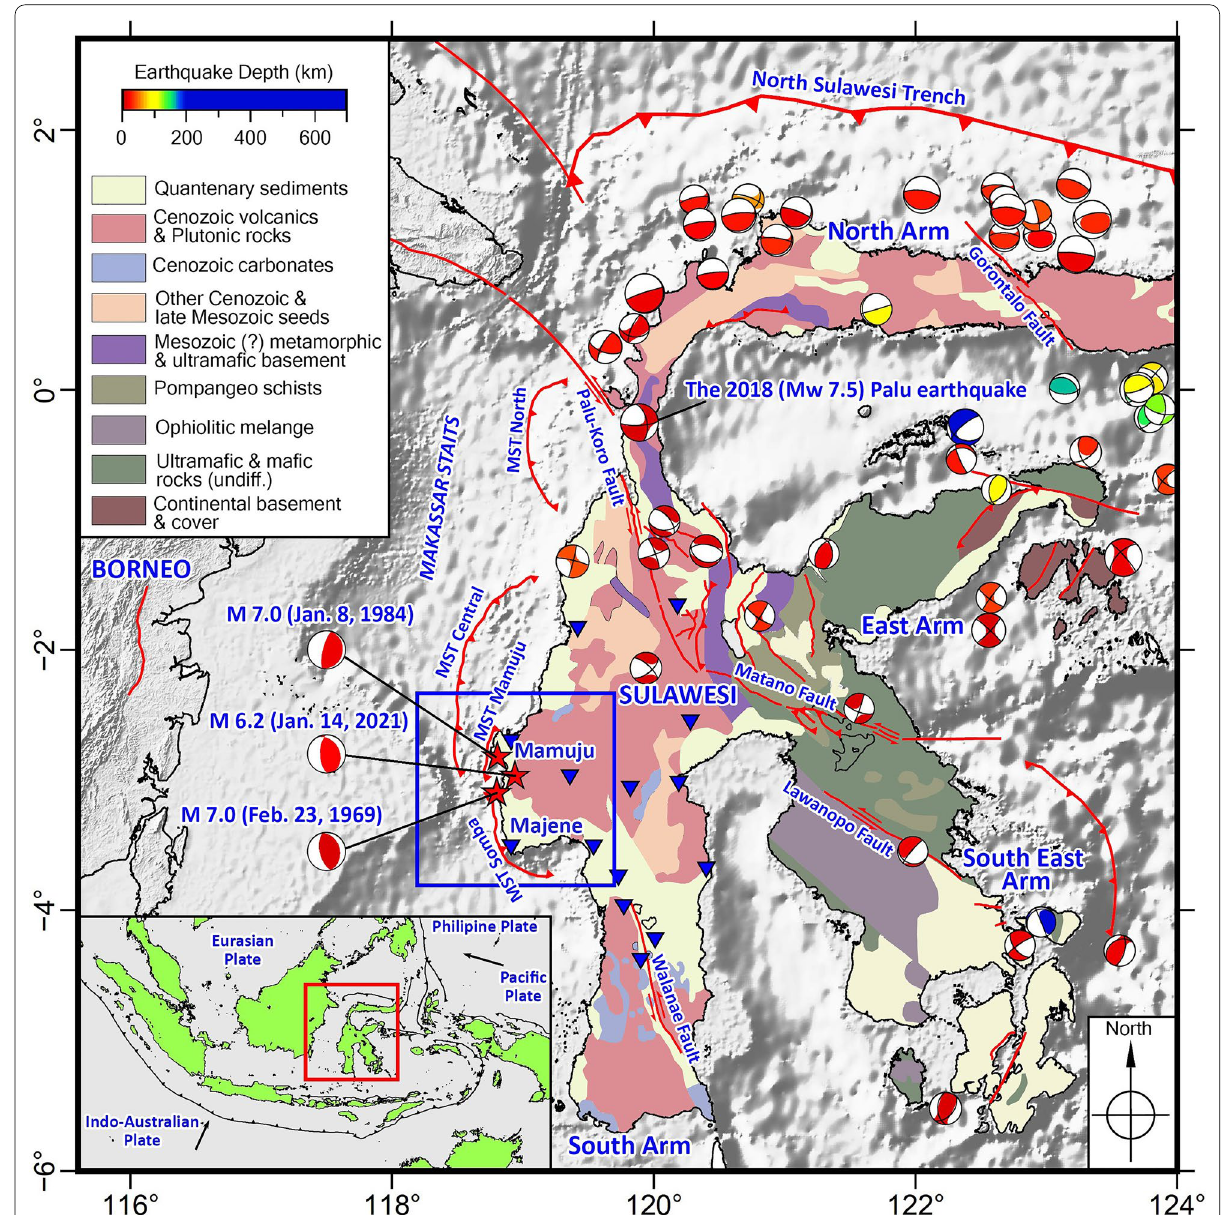
Fig. 1 Map of the Sulawesi region, with the study area denoted by a blue box. Geological features are taken from Watkinson (2011). The three red stars depict the 15 January 2021 (Mw 6.2) mainshock from BMKG and the historical destructive earthquakes around Mamuju are taken from the USGS earthquake catalog. The historical seismicity ( M 6.0) and Centroid Moment Tensor (CMT) solutions for the entire Sulawesi region in the time ≥ period 1977 to 2020 are taken from the global CMT catalog, except for the 1969 ( M 7.0) event taken from Fitch (1972) and the 2021 ( M 6.2) event from the BMKG catalog. The blue inverted triangles are the BMKG seismic stations used in earthquake relocation process; red traces represent major crustal faults in the region extracted from Irsyam et al. (2017). The inset map shows the Indonesian region, together with Indo-Australian and